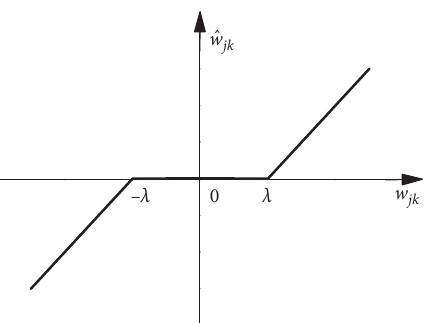
Figure 3: Soft threshold function graph.